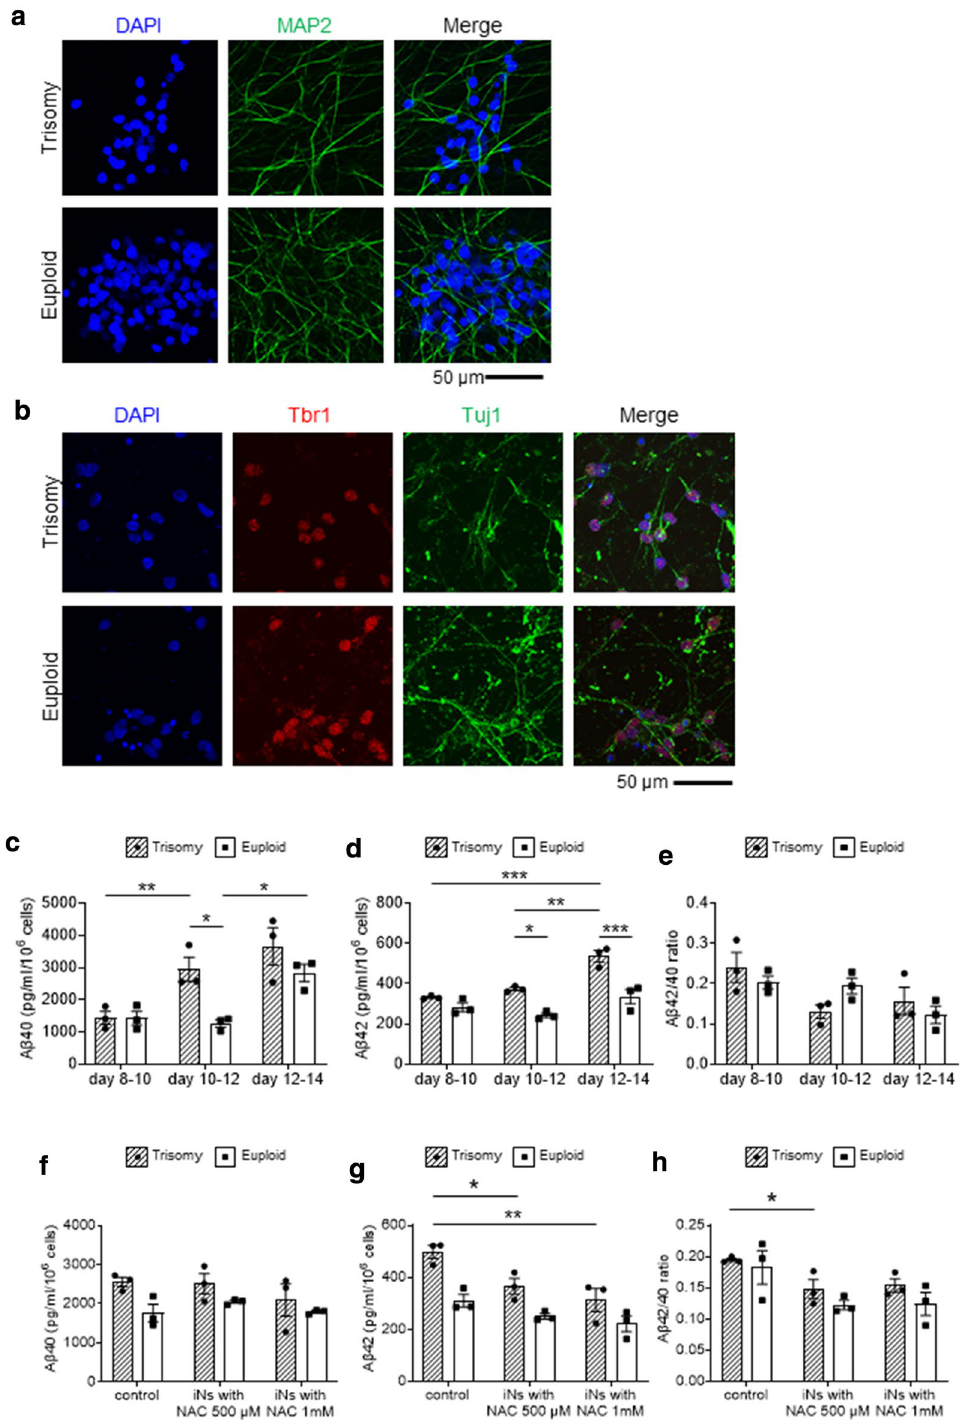
Figure 6. Verification with another isogenic PSC pair. (a,b) Immunostaining of ESC-derived neurons on day 14. ( c,d) Amount of secreted Aβ40 (c) and Aβ42 (d) from ESC-derived neurons at the indicated periods. ( e) The Aβ40/Aβ42 ratio at each period. ( f–h) Amount of secreted Aβ40 (f) and Aβ42 (g) from iNs and the Aβ40 / Aβ42 ratio (h) at day 10. NAC at the indicated concentrations was added on day 8. Data are means ± SEM from three independent experiments; ***, p < 0.001; **, p < 0.01; *, p < 0.05; two-way ANOVA test followed by Tukey’s Multiple Comparison Test. Two-way ANOVA found no significance in (e,f) : interaction p values were 0.1242 (e) and 0.5453 (f)